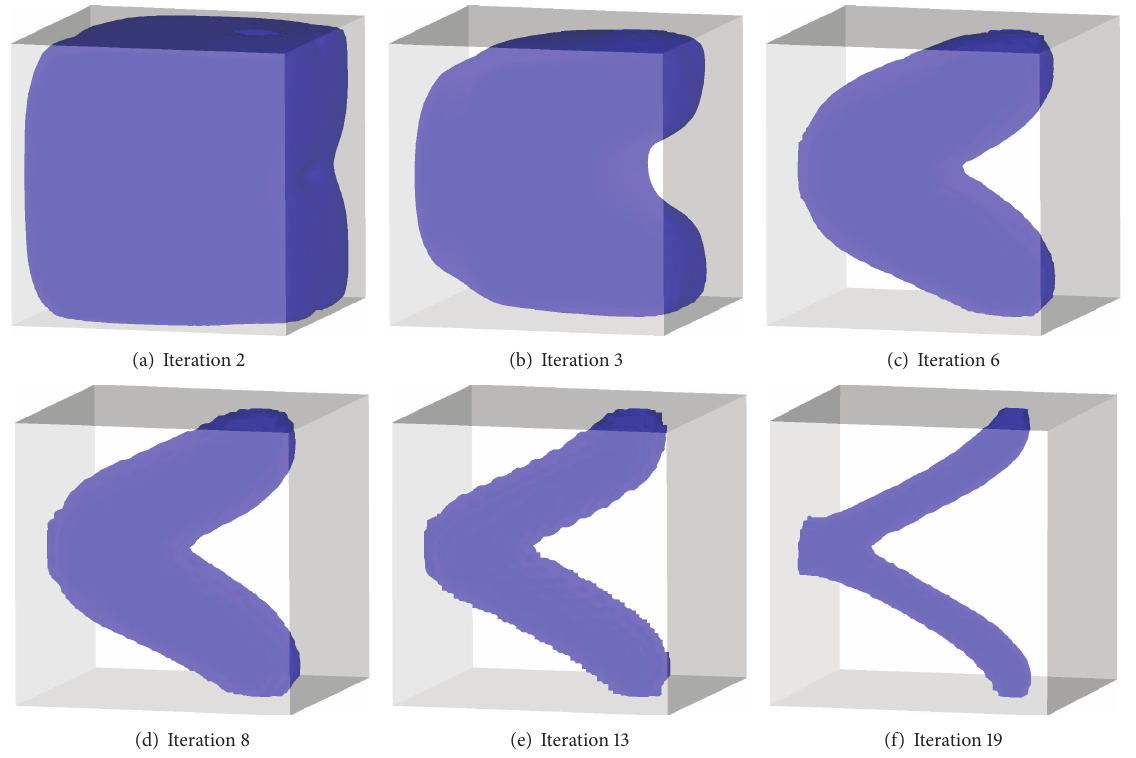
Figure 4: The obtained geometries during the optimization process.